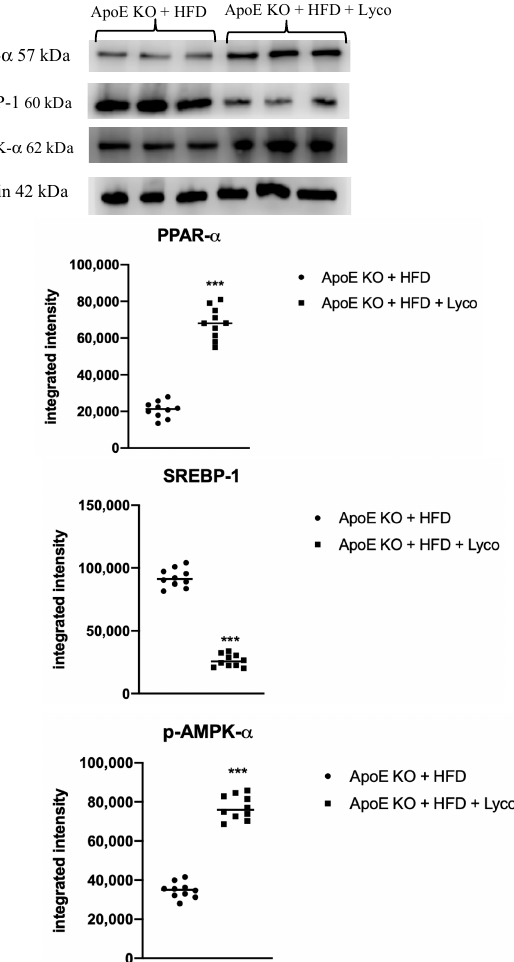
Figure 7. Western blot analysis of PPAR- α , SREBP-1c, and p-AMPK- α in liver samples. Values were obtained from 10 animals per group and are expressed as the means and SD. *** p < 0.0001 vs. ApoE KO + ND.